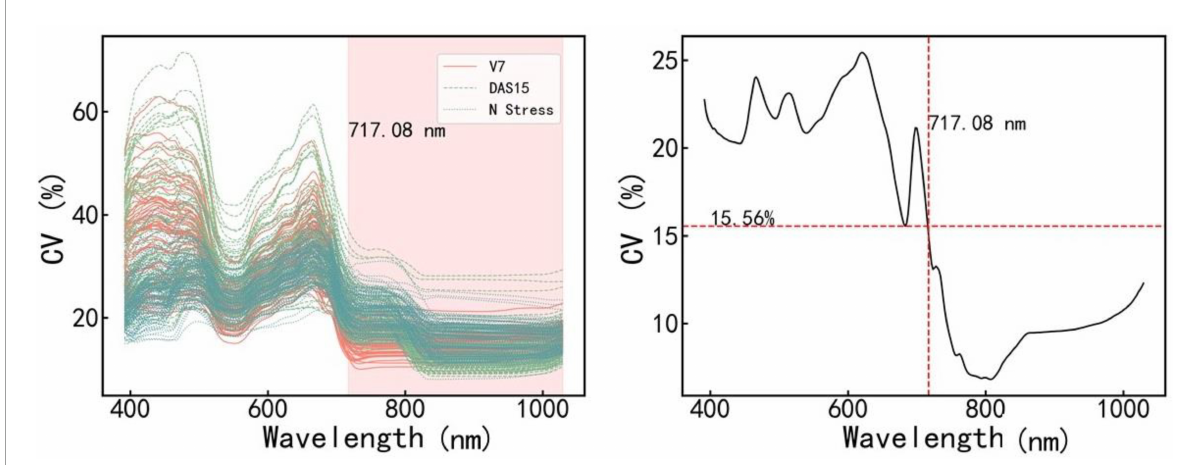
FIGURE3 The coefficient of variation (CV) values of different samples (Left) and all samples (Right) in various bands. V7 and DAS15 represent the samples obtained at two sampling dates under different N treatments, respectively. N stress represents the samples obtained in the N starvation treatment experiment. V7 indicates that the maize is in the stage of the seventh fully unfolded leaf; DAS15 means the 15th day after maize silk.